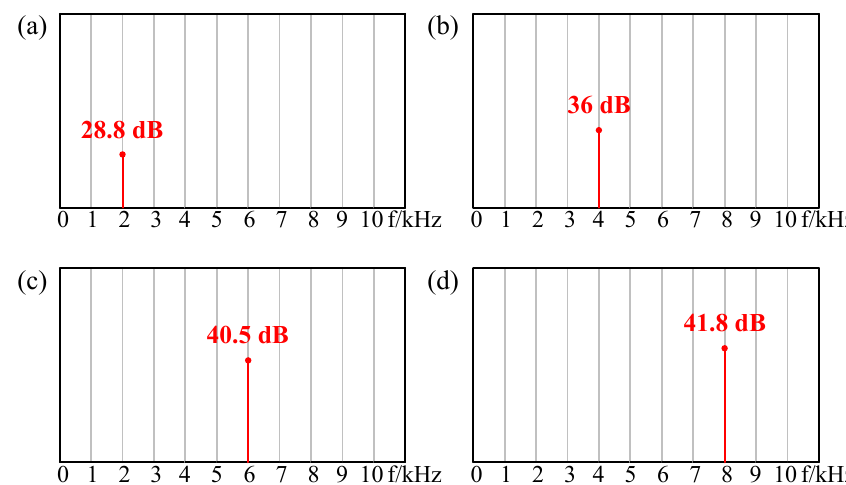
Figure 8. Relationship of SPL with the frequency.